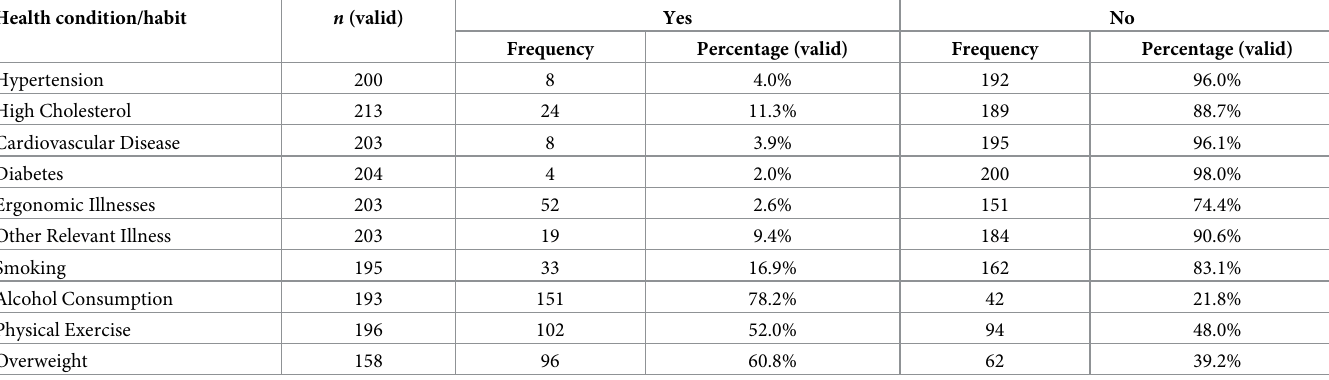
Table 2. Prevalence of self-reported health issues and lifestyle